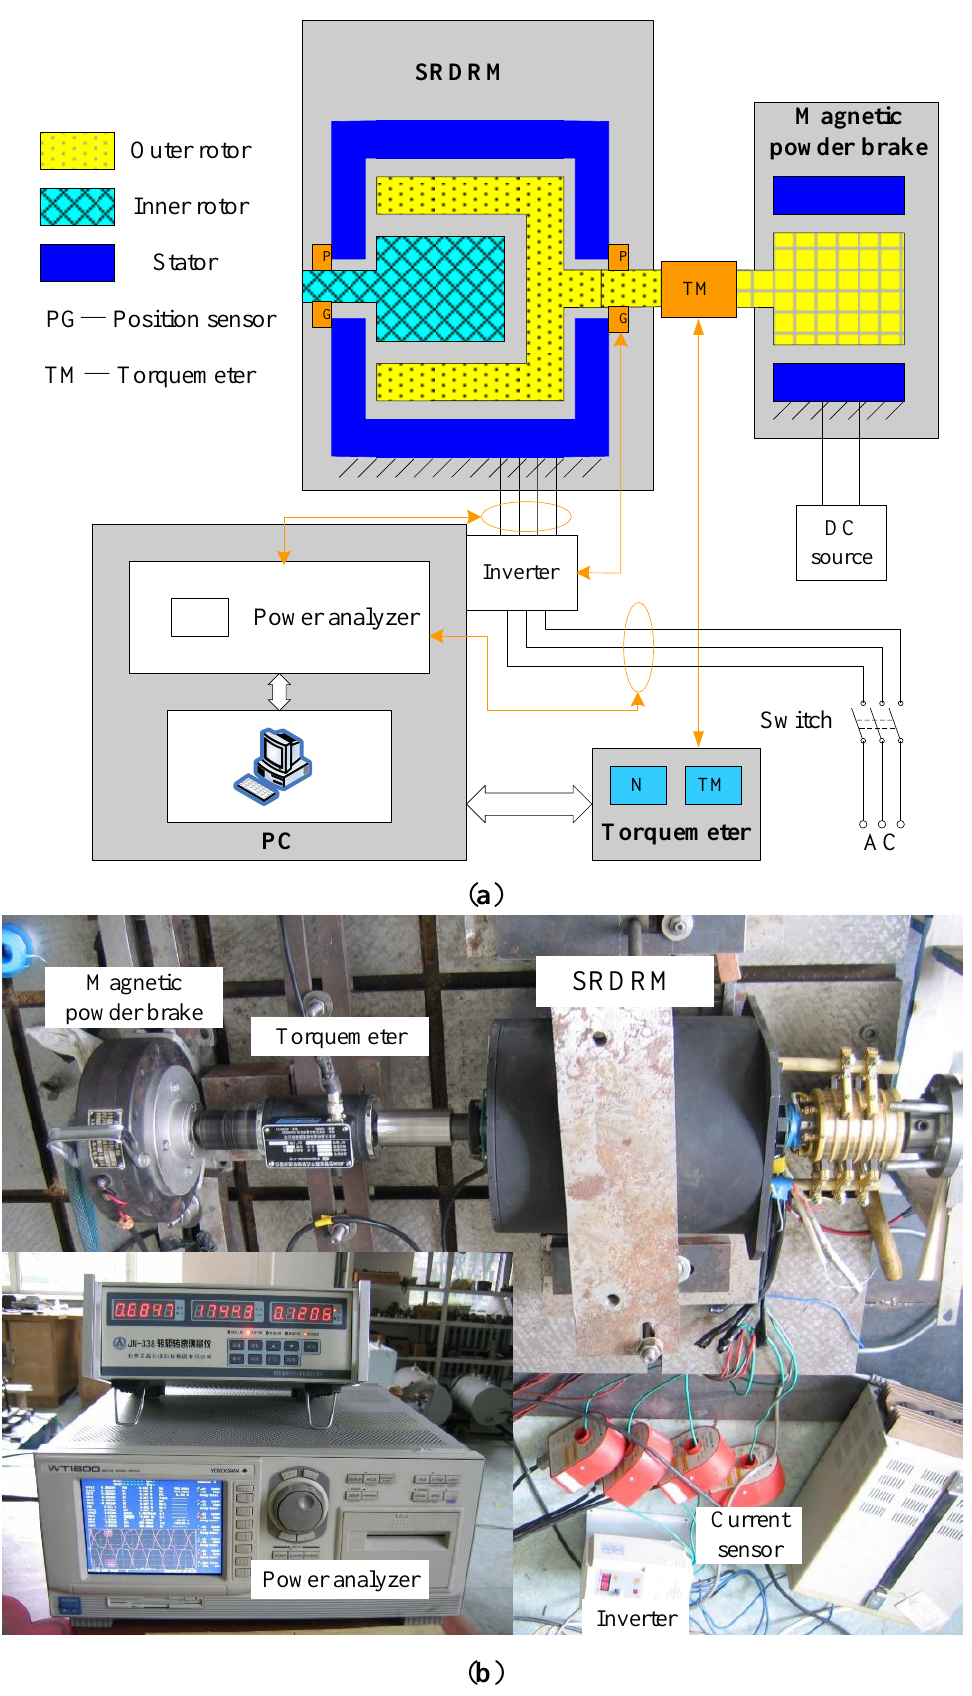
Figure 29. The experimental test bench: ( a ) Schematic diagram of test bench; ( b ) The experimental test